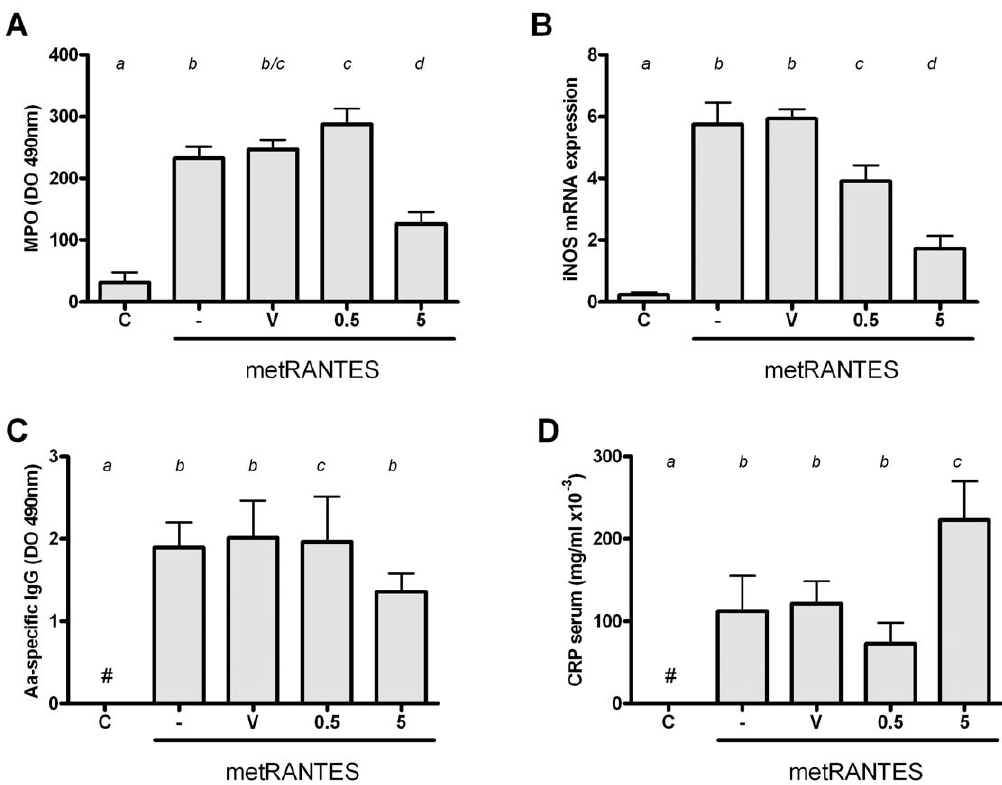
Figure 5. The effect of distinct met-RANTES doses treatment in the control of A.actinomycetemcomitans infection. C57Bl/6 mice were infected orally with AA , treated with met-RANTES at 0.5 and 5 mg doses or (V) veicule, (-) non treated and (C) control non-infected mice, sacrificed at day 30 post-infection and evaluated for: A) levels of myeloperoxidase (MPO) in periodontal tissues; B) levels of inducible nitric oxide syntase (iNOS) expression; C) levels of Aa-specific IgG; and D) levels of C reactive protein (CRP) in serum; all performed as described in Material and methods. Different italic low case letters represent statistically significant differences among the doses in the same experimental group (P , 0.05; One-way